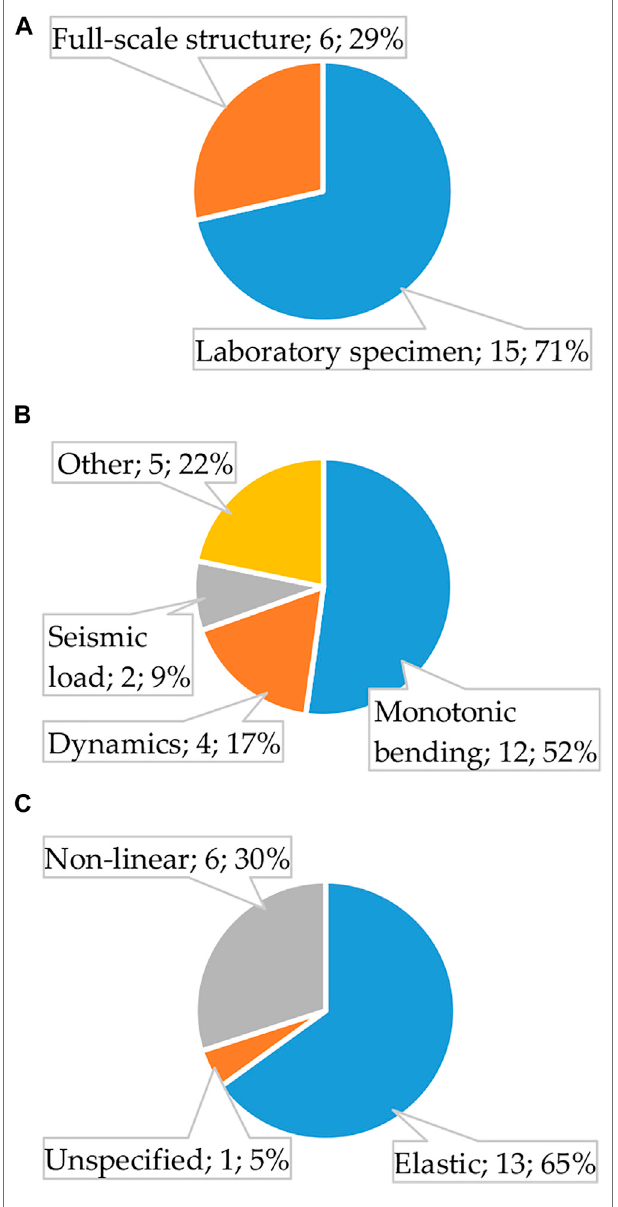
FIGURE 1 | Structure of the literature publications related to numerical modeling: (A) Distribution by the modeling object; (B) Loading situation; (C) Speci fi edmaterialparameters.Note:theindicatedcases ’ numbercanexceed the articles ’ number because of the research object